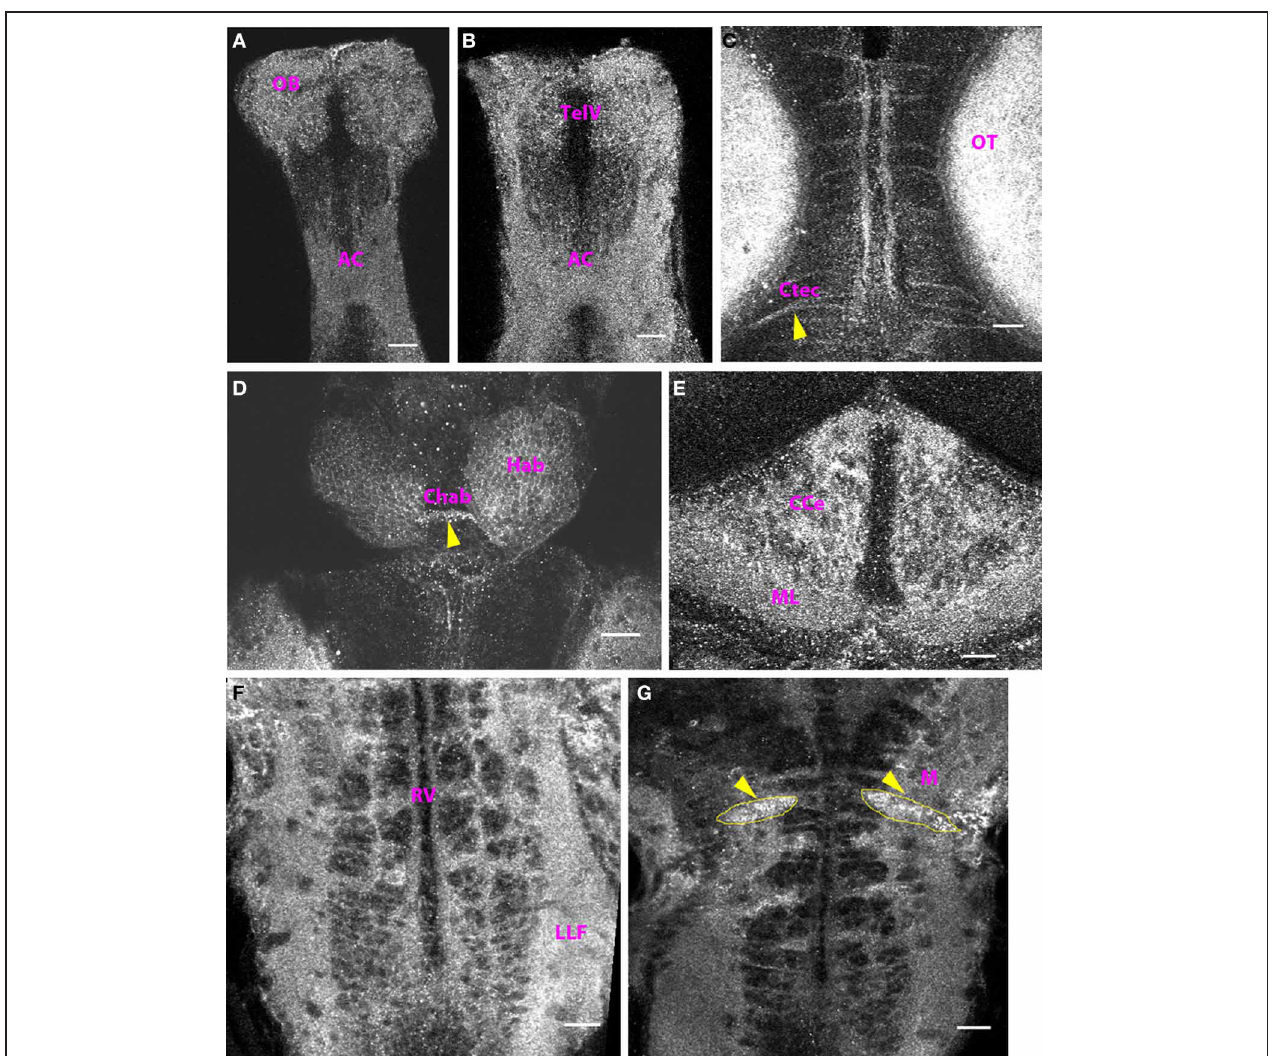
FIGURE 7 | Cx35 staining pattern in the CNS of 15dpf zebrafish. Larvae are dorso-ventrally placed with anterior on top in all panels. All panels show single optical sections taken at a z-resolution of 0.44 µ m. (A) Ventral telencephalon showing punctate Cx35 immunoreactivity in the anterior commissure (AC) and the olfactory bulb (OB). (B) Telencephalon 50 µ m from the ventral surface showing staining in the anterior commissure (AC) and in the olfactory bulb (OB). The telencephalic ventricle (TelV) can be seen. (C) Mesencephalon, dorsal view showing staining in the optic tectal (OT) neuropil and in intertectal commissures (Ctec, arrowhead). (D) Habenulae